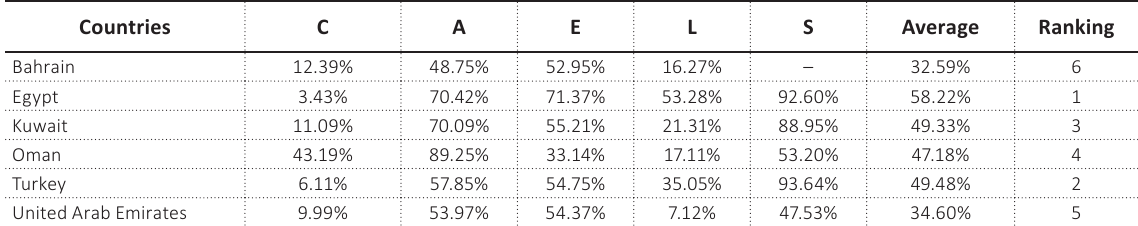
Table 3. CAELS 100 results and ranking of the six countries studied